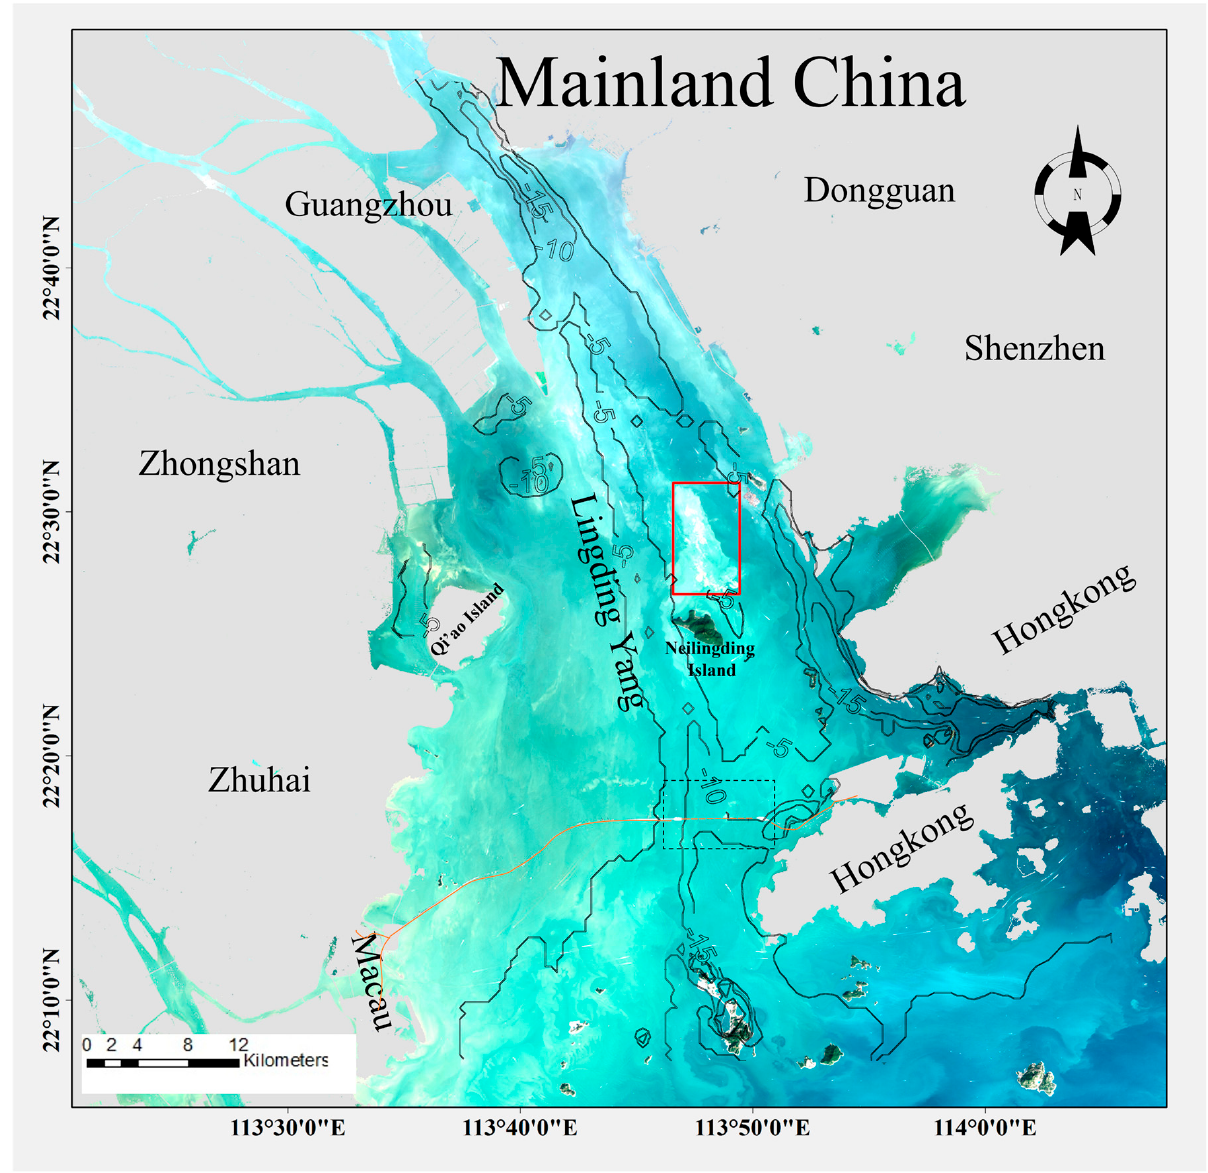
Figure 1. A map of the study area. The color is the water area extracted from the true color image of the Landsat-8 data acquired on January 3rd, 2015. The gray line is the isobath from the GEBCO bathymetric data. The red rectangle is the permitted sand excavation region, and the black rectangle is the tunnel construction area. The solid orange line is the bridge, and the dotted orange line is the undersea tunnel.